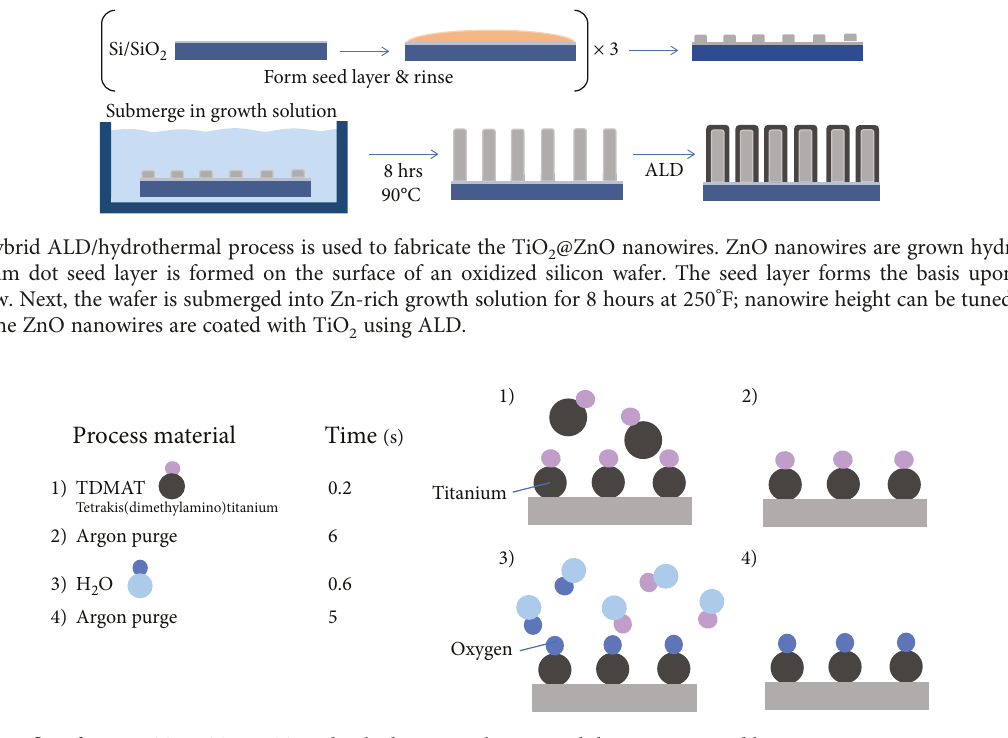
. TDMAT is adsorbed onto a substrate and the excess purged by argon. Next, H 2 O and by-products are purged by 2